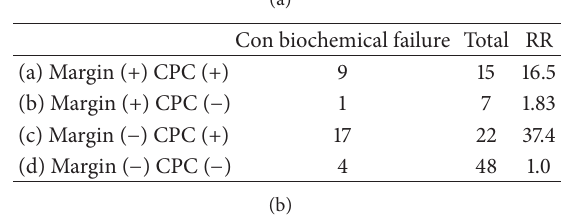
Table 4: (a) Association of CPC status and margin status with biochemicalfailure.(+)positive( − )negative,(b)AssociationofCPC status and capsule status with biochemical failure, (c) Association of CPC status and perineural infiltration with biochemical failure, (d) Association of CPC status and vascular infiltration with biochemical failure, (e) Association of CPC status and lymphatic infiltration with biochemical failure.